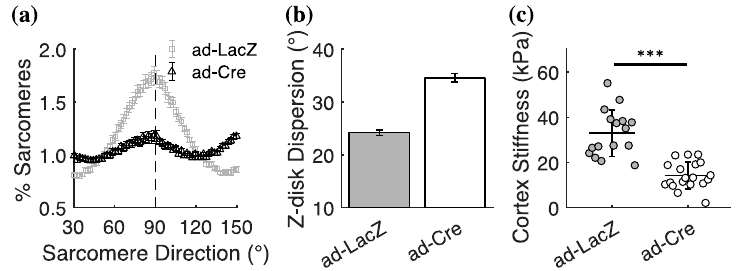
Figure 4. Neonatal ventricular mouse cardiomyocytes (NMVCMs) also exhibit significant structural and mechanical adaptations in response to FLNC deletion. ( a ) Fewer sarcomeres have Z-disks aligned perpendicularly (90°) to the long axis of the cell in NMVCMs infected with ad-Cre (FLNC-knockdown; black symbols) compared with ad-LacZ (controls; gray symbols), causing the angular dispersion of Z-disk orientation ( b ) to be greater in ad-Cre NVMCMs with ad-LacZ. ( c ) AFM revealed a significant decrease in the passive transverse stiffness of the cell membrane/cortex of NMVMs lacking FLNC (ad-Cre) compared with controls (ad-LacZ). *** p < 0.0005 for unpaired student’s t -test. N = 2 and n = 16 for ad-LacZ, N = 2 and n = 19 for ad-Cre.